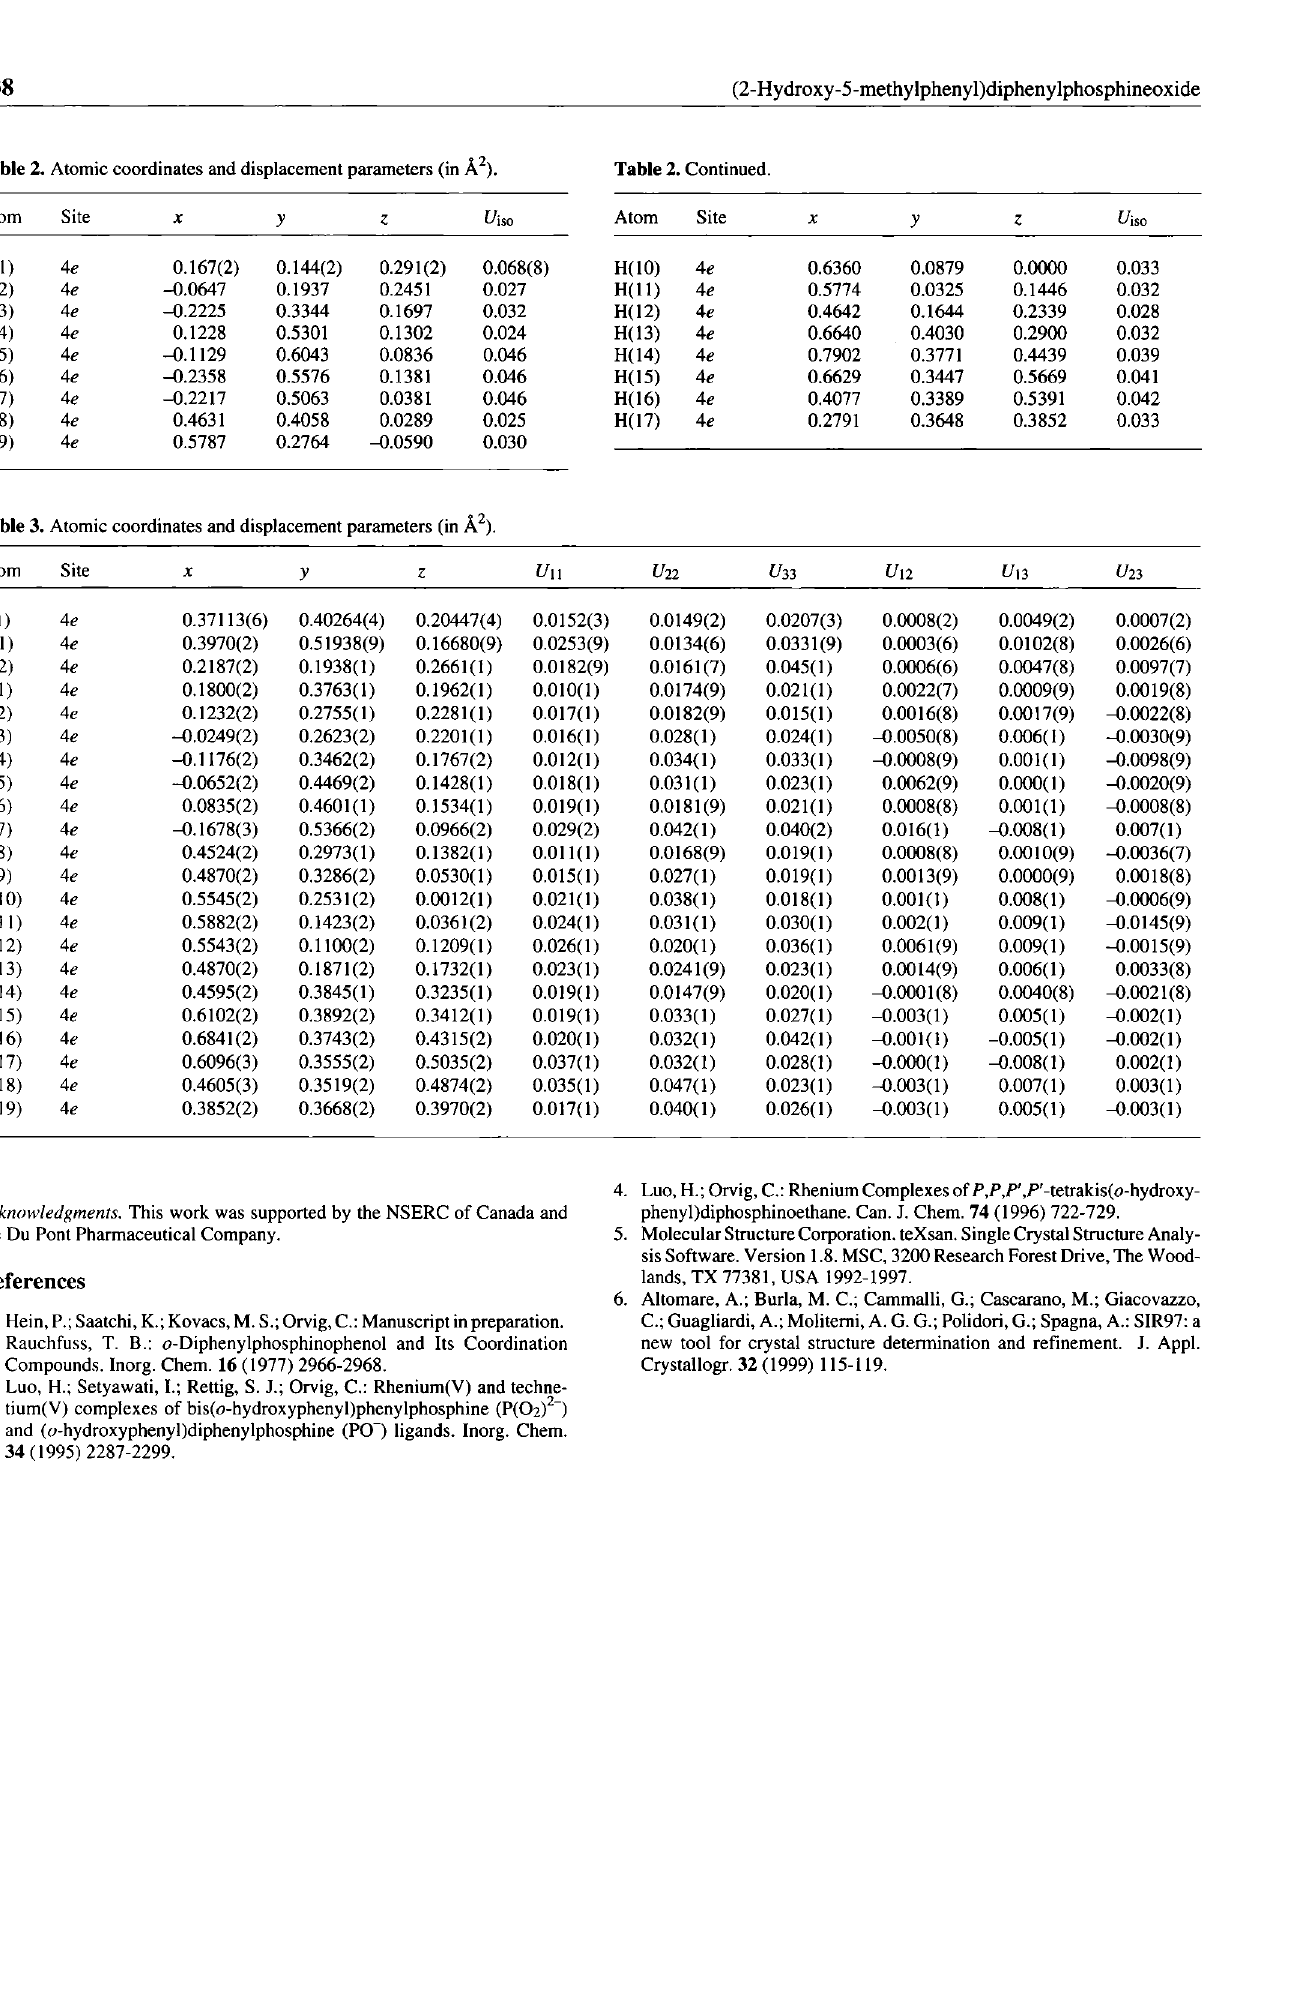
Table 2. Atomic coordinates and displacement parameters (in Ä 2 ). Table 2. Continued.